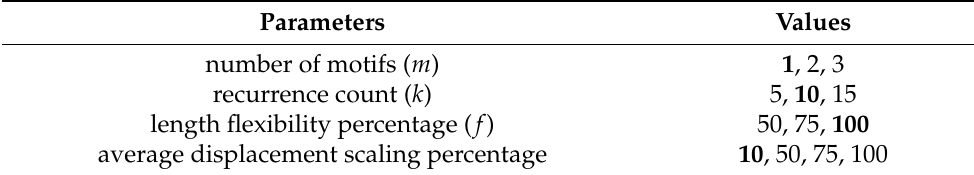
Table 2. Experimental settings; default values are highlighted in